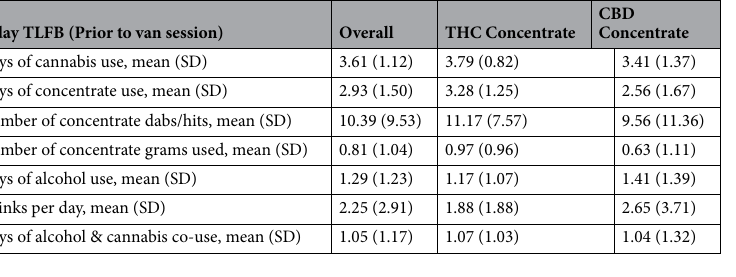
Table 2. Descriptive data on typical patterns of cannabis and alcohol use prior to the experimental session